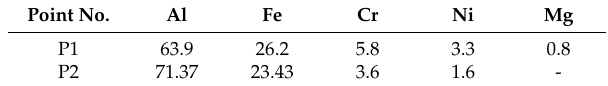
Table 4. Chemical compositions at different points near aluminum/fusion zone interface (at %). Point No. Al Fe